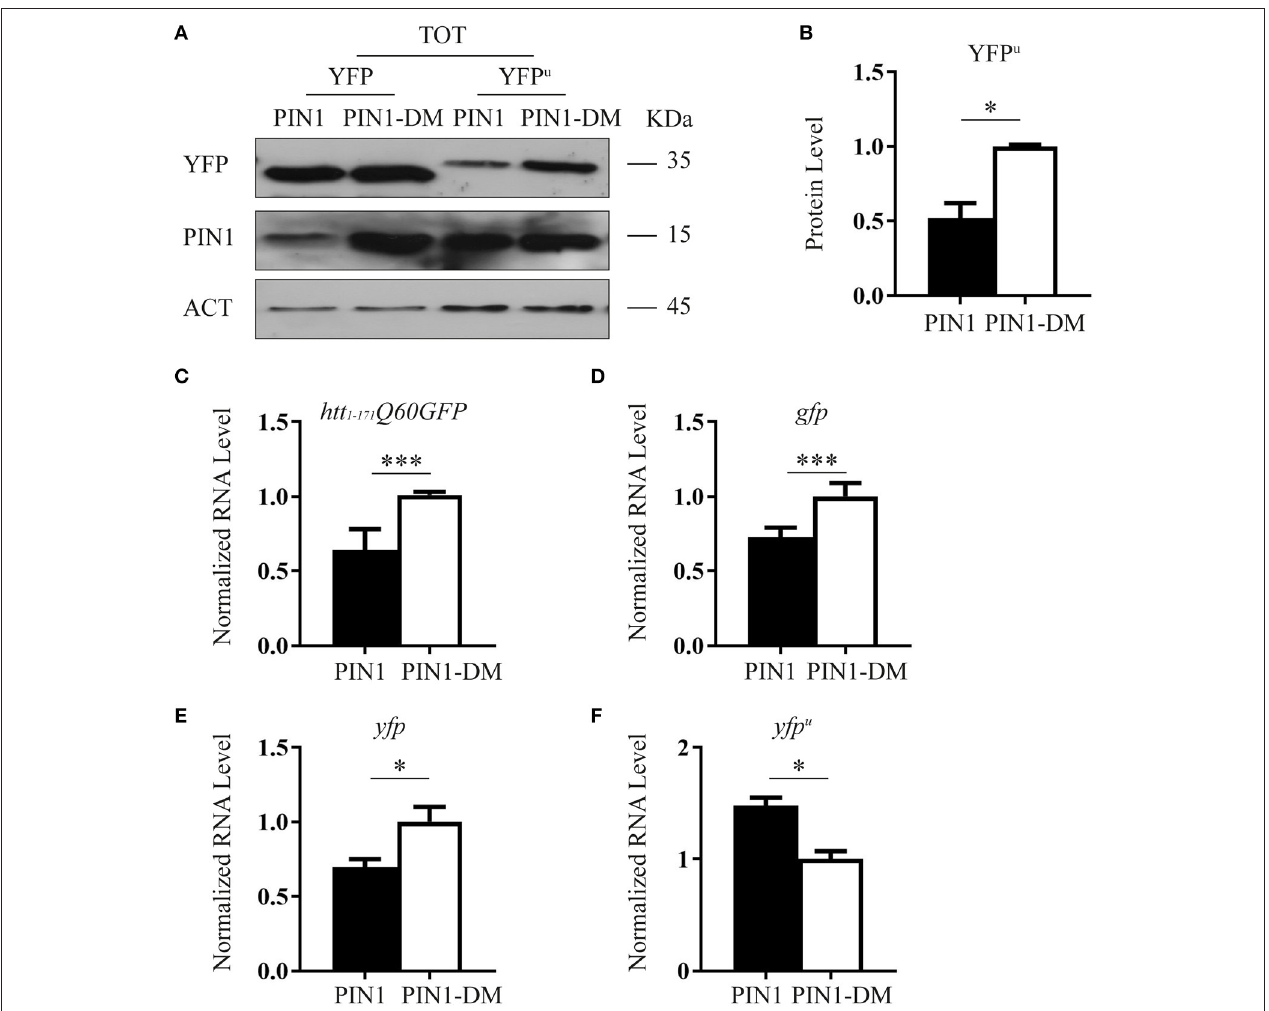
FIGURE 6 | PIN1 stimulates UPS activity. (A) HEK293 cells were co-transfected with YFP u or YFP and HA-PIN1 or HA-PIN1DM. Cells were harvested for analysis 48h after transfection. Representative western blot showing YFP, YFP u , PIN1, and β -ACTIN as loading control. (B) Relative protein level quantification of YFP u in the presence of PIN1 as compared to PIN1DM. (C–F) qPCR analysis of the expression levels of htt 1 – 171 Q60GFP (C) , gfp (D) , yfp (E) , and yfp u (F) in the presence of PIN1 as compared to PIN1DM. (C,D) Data are the mean ± SEM from 4 independent experiments using 2 different batches of cells. (E,F) Data are the mean ± SD from 3 independent experiments. *** P < 0.001, * P < 0.05. Asterisk indicates the statistically significant difference in the level of protein and